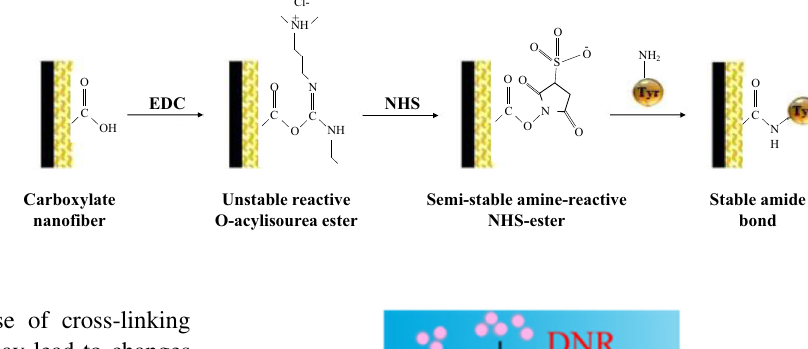
Fig. 4 Schematic representation of tyrosinase immobilized in nano fi ber mats by EDC/NHS activation [90]